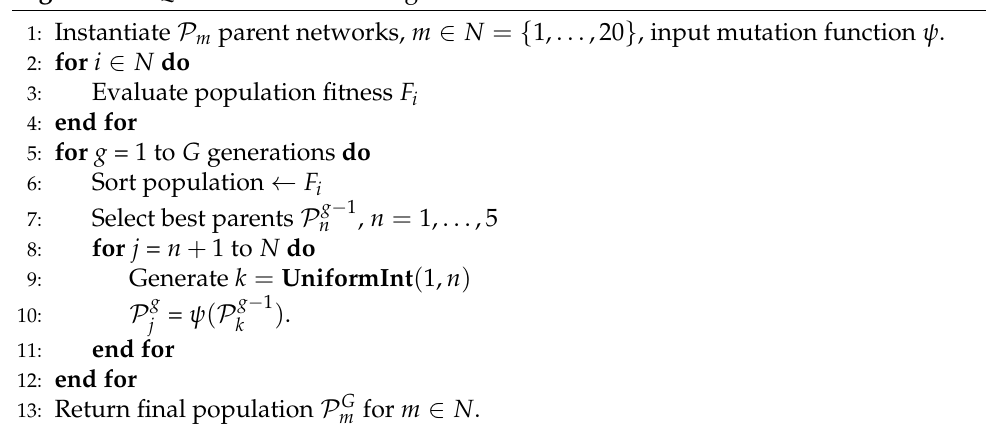
Algorithm 1 Quaternion Genetic